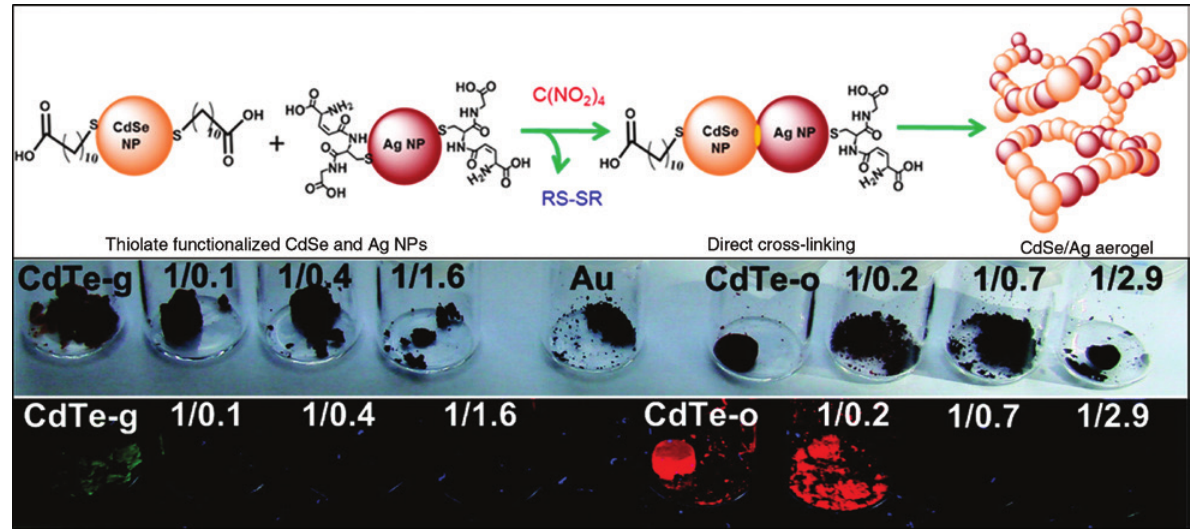
Figure 7: (Top) Reaction showing the formation of an aerogel consisting of AgNPs and CdSe QDs through the process of ligand removal. (Middle) Aerogels made of green fluorescing (CdTe-g) and orange fluorescing (CdTe-o) CdTe QDs with AuNPs. The ratios given refer to the ratio of CdTe to gold in the shown aerogel. (Bottom) Fluorescence of aerogels of varying composition. Only (Top) is reprinted from Ref. [83]. (Middle) and (bottom) are reprinted from Ref. [82], which is also from ACS, but from 2011. Copyright 2011 and 2015 American Chemical